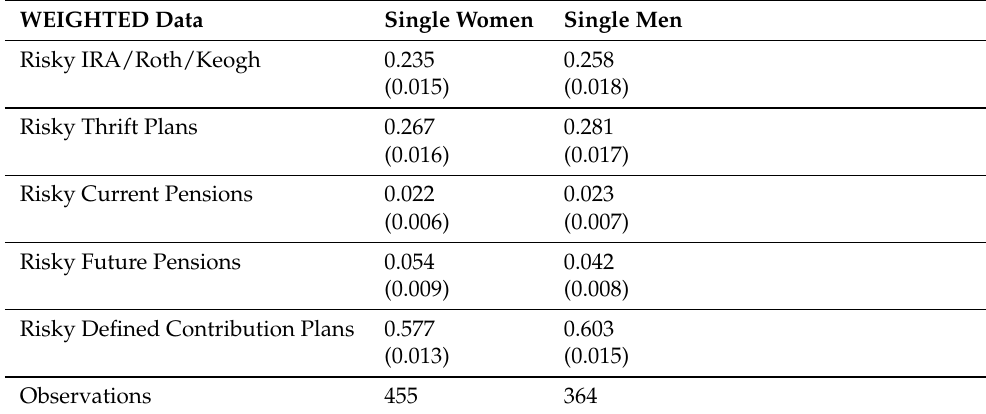
Table 8. Mean Risky Shares of Single Females and Single